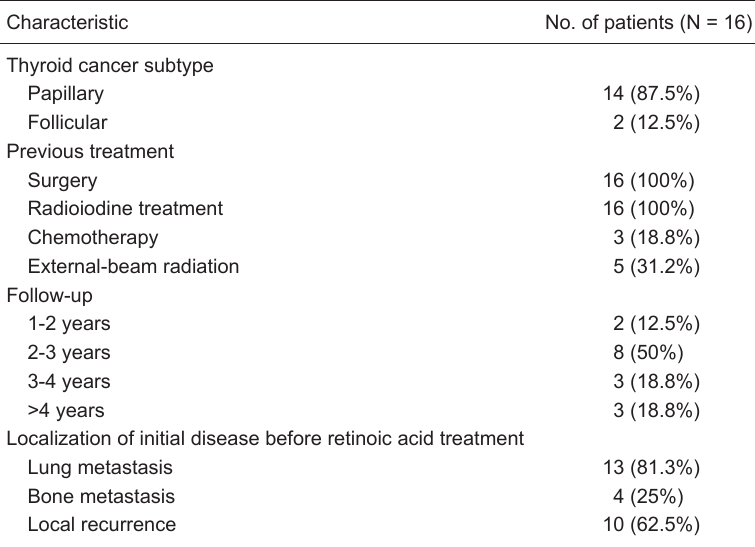
Table 1. Baseline characteristics of the patients treated with retinoic acid.